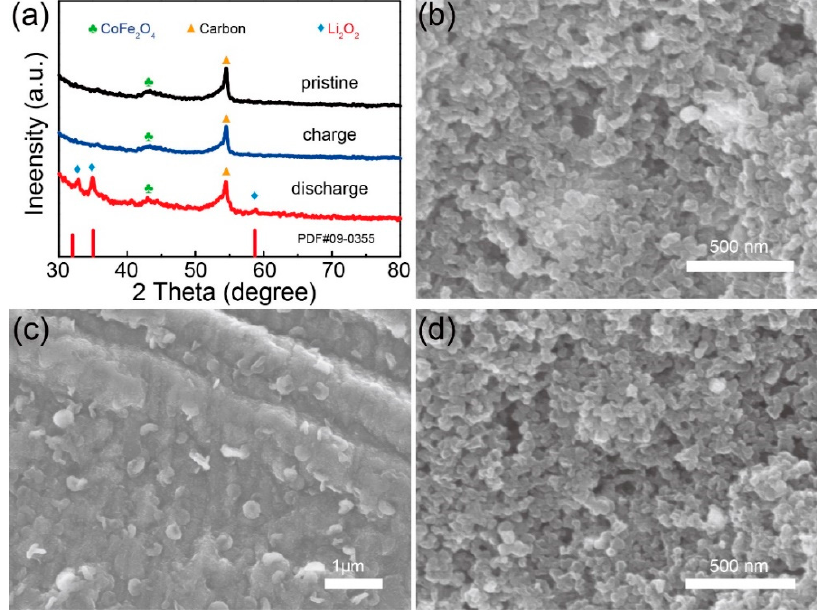
Figure 5. ( a ) XRD patterns of CoFe 2 O 4 /g-C 3 N 4 electrode in different states; SEM images of CoFe 2 O 4 /g-C 3 N 4 electrode in ( b ) pristine state, ( c ) 1st discharged state, and ( d ) 1st charged states.